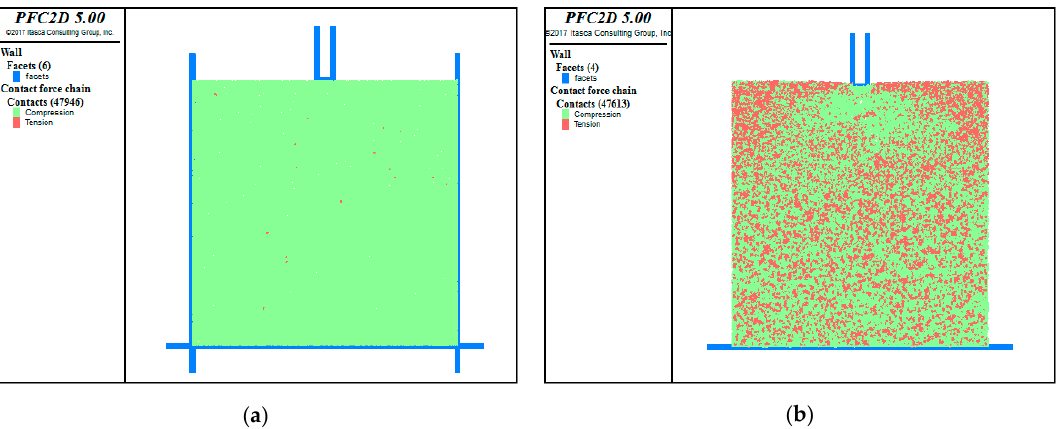
Figure 14. Comparison of internal contact tension and pressure distribution before and after the test. ( a ) Before the test; ( b ) After the test.